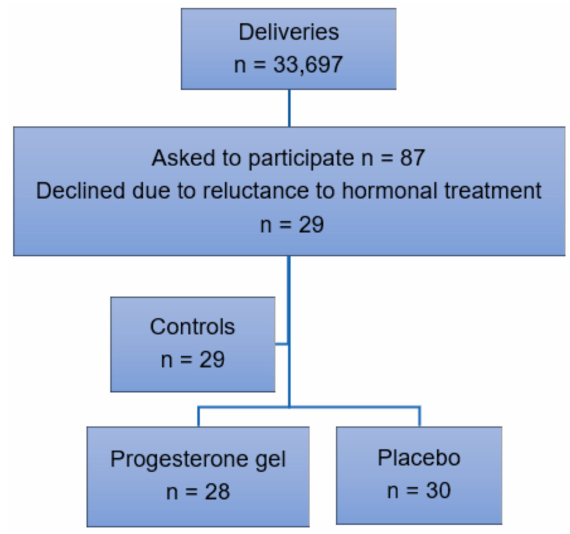
Figure 1. Inclusion of participants in